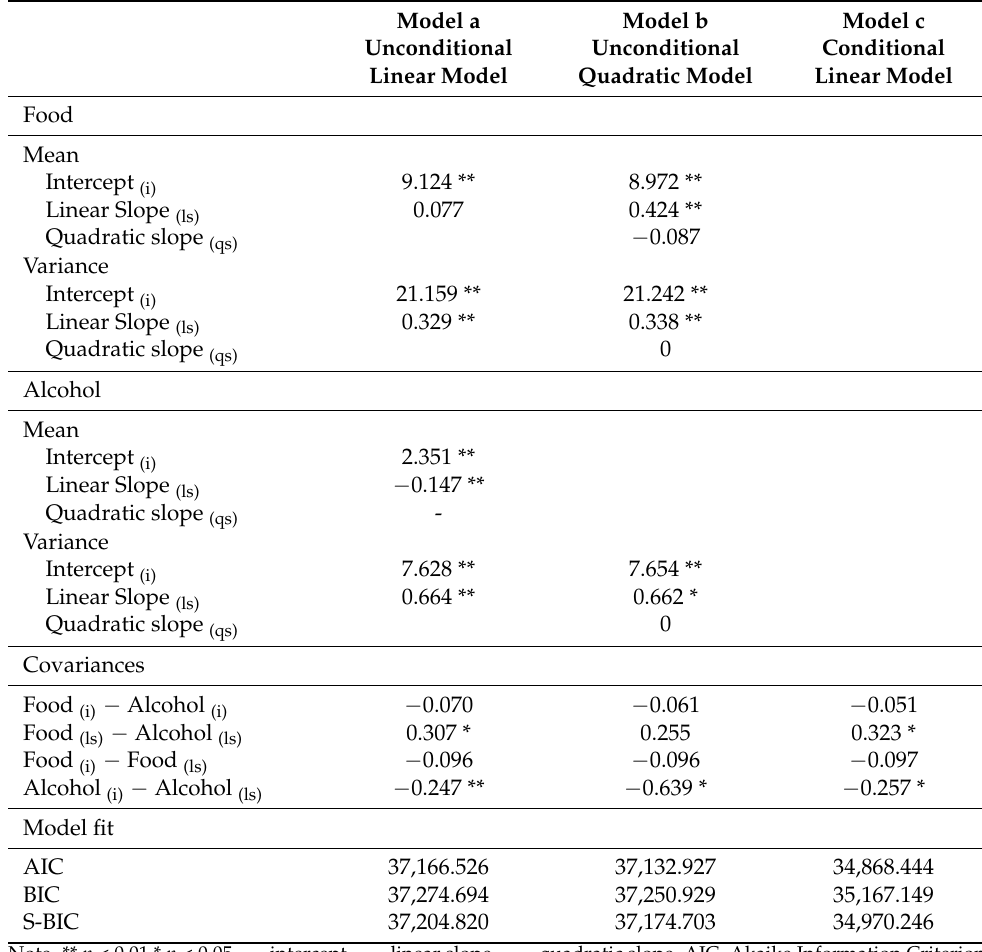
Table 2. Parameter estimates and model fit for the unconditional and conditional latent growth curve modeling analyses of unhealthy food and alcohol